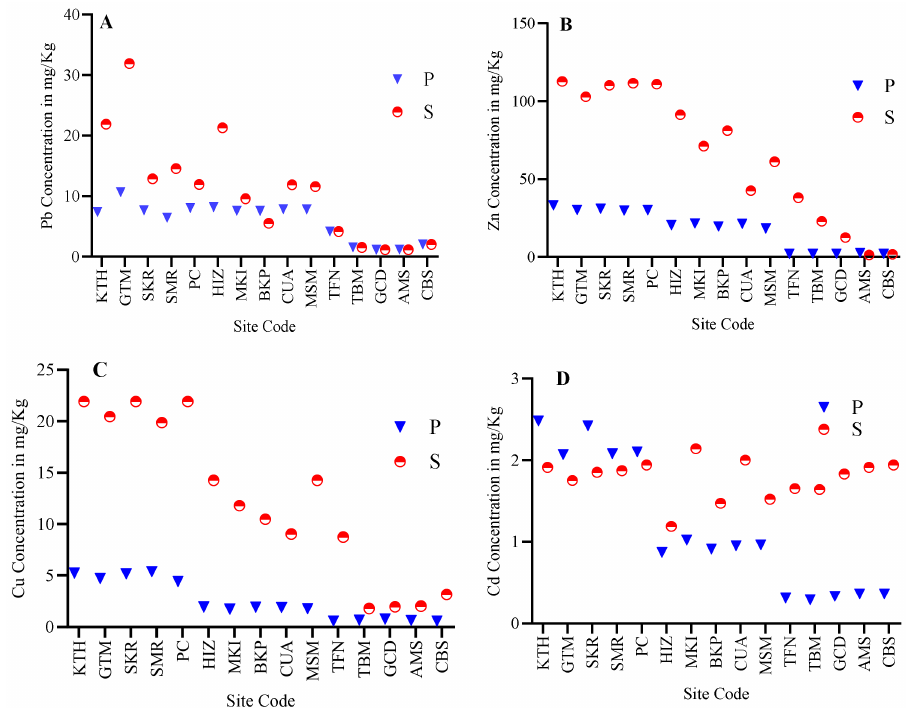
Figure 2. Bio-concentration of Pb, Zn, Cu, and Cd in plants (mg/kg) total dry biomass and its concentration in soil collected from different abandoned habitats in Khyber Pakhtunkhwa, Pakistan. Note: P (Plant), S (Soil), Threshold levels: Pb = 5 mg/kg [43], Zn = 60 mg/kg: Cu = 10 mg/kg [44], Cd = 0.1 mg/kg [45] in plants while for soil while Pb = 8.15 mg/kg, Zn = 44.19 mg/kg, Cu = 8.39 mg/kg [46] and for Cd = 0.31 mg/kg [47]. ( A – D ) (Sub-Figure for Pb, Zn, Cu and Cd,